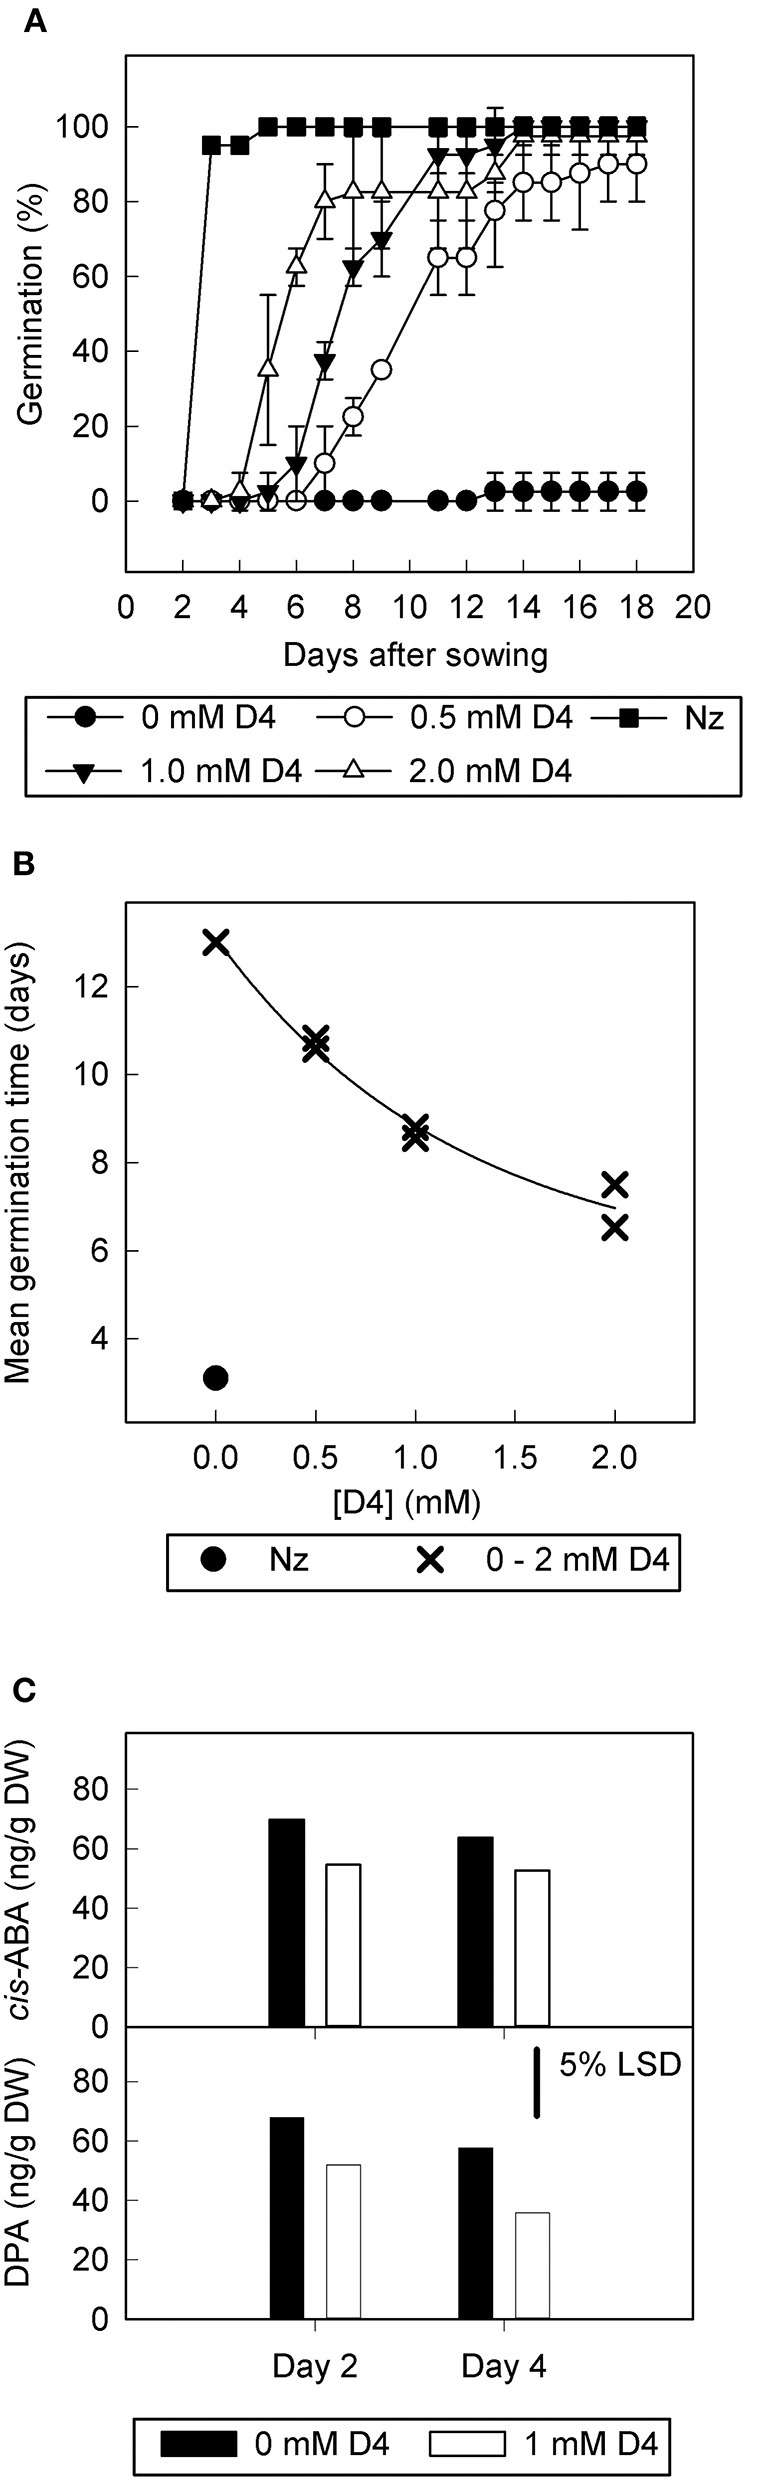
The effect of D4 on germination, abscisic acid, and dihydrophaseic acid content of tomato seed overexpressing LeNCED1. Seed of transgenic line sp12 were imbibed on filter paper wetted with 0–2.0 mM D4, or with 1.8 mg l−1 norflurazon (Nz), in sterile water containing 1% DMSO and 0.2 mM NaOH. (A) Percentage germination over time plotted for 0 mM D4, 0.5 mM D4, 1.0 mM D4, 2.0 mM D4, and 1.8 mg l−1 norflurazon (Nz). (B) Mean germination time (radicle emergence) at 0–2.0 mM D4 and 1.8 mg l−1 norflurazon. (C), abscisic acid (ABA) and dihydrophaseic acid (DPA) content of imbibed but ungerminated seed of sp12, imbibed with and without 1 mM D4 for 2 or 4 days. LSDs at the 5% level from ANOVA are indicated, n = 4.